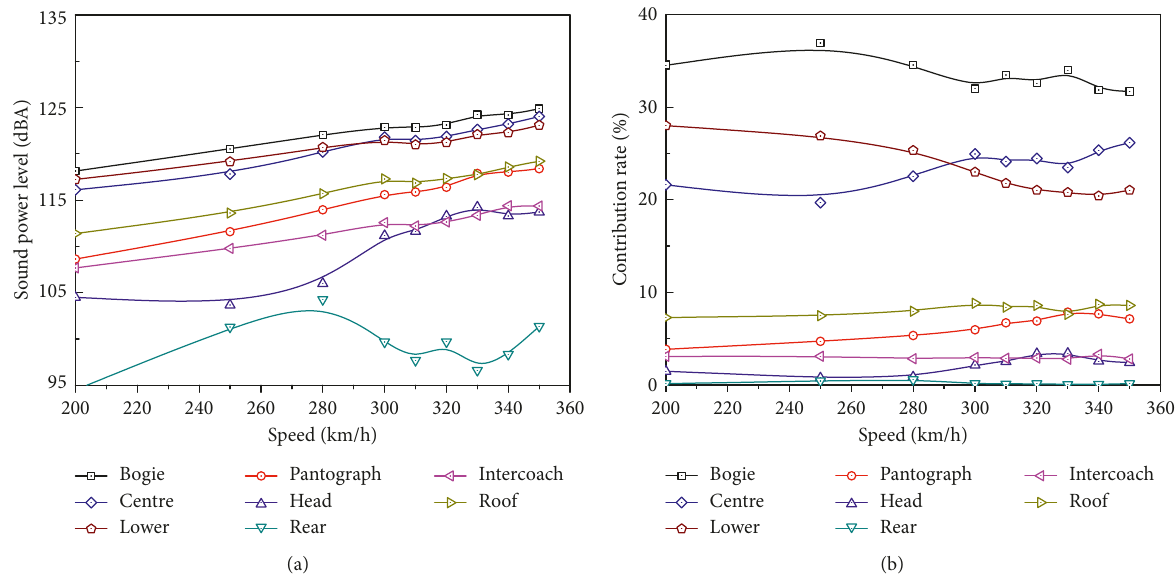
Figure 9: Exterior sound sources’ characteristics and their contribution rates at different speeds. (a) Sound power levels of exterior sources in different regions. (b) Contribution rates of the exterior sources to total sound power.